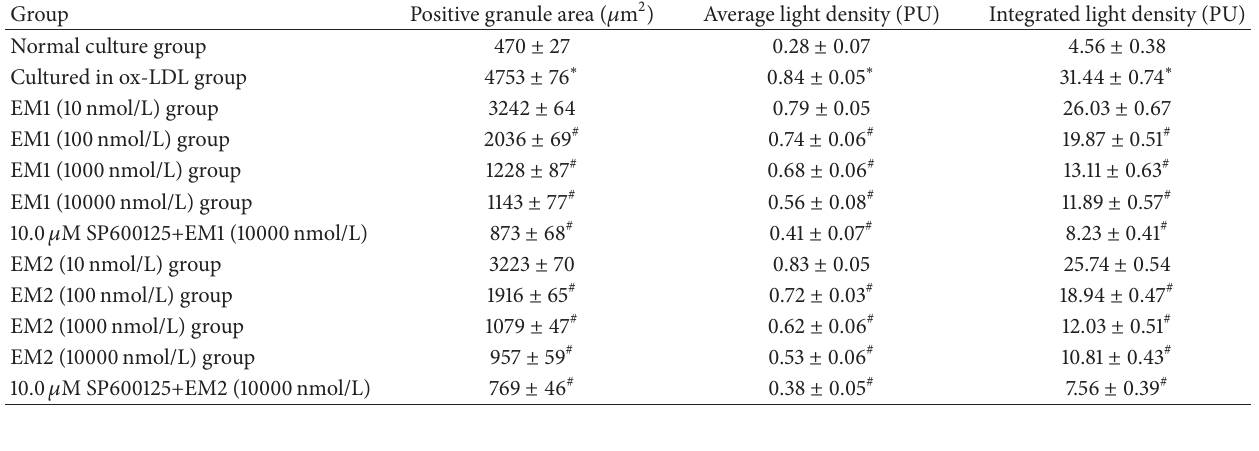
Table 1: The positive granule area, average light density, and integrated light density of p-JNK in HUVECs induced by ox-LDL increased for 48 h and prevented by EM1/EM2 by image-pro plus. Data is expressed as mean ± SD. ∗ 𝑃 < 0.05 versus control. # 𝑃 < 0.05 versus ox-LDL.